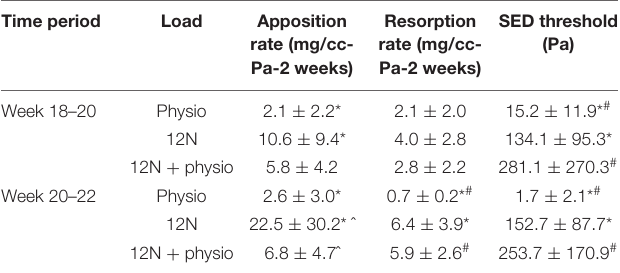
TABLE 1 | Bone adaptation parameters obtained from optimizing the predicted and experimental images under different loading conditions. Time